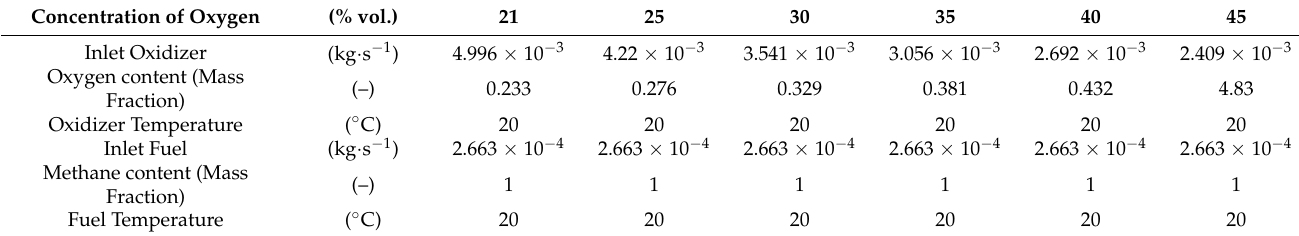
Table 4. Boundary condition Fuel and